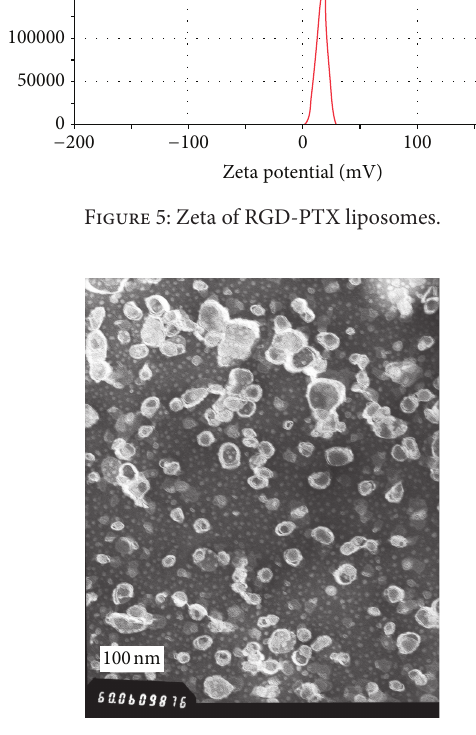
Figure 6: Typical TEM images of RGD-PTX liposomes.